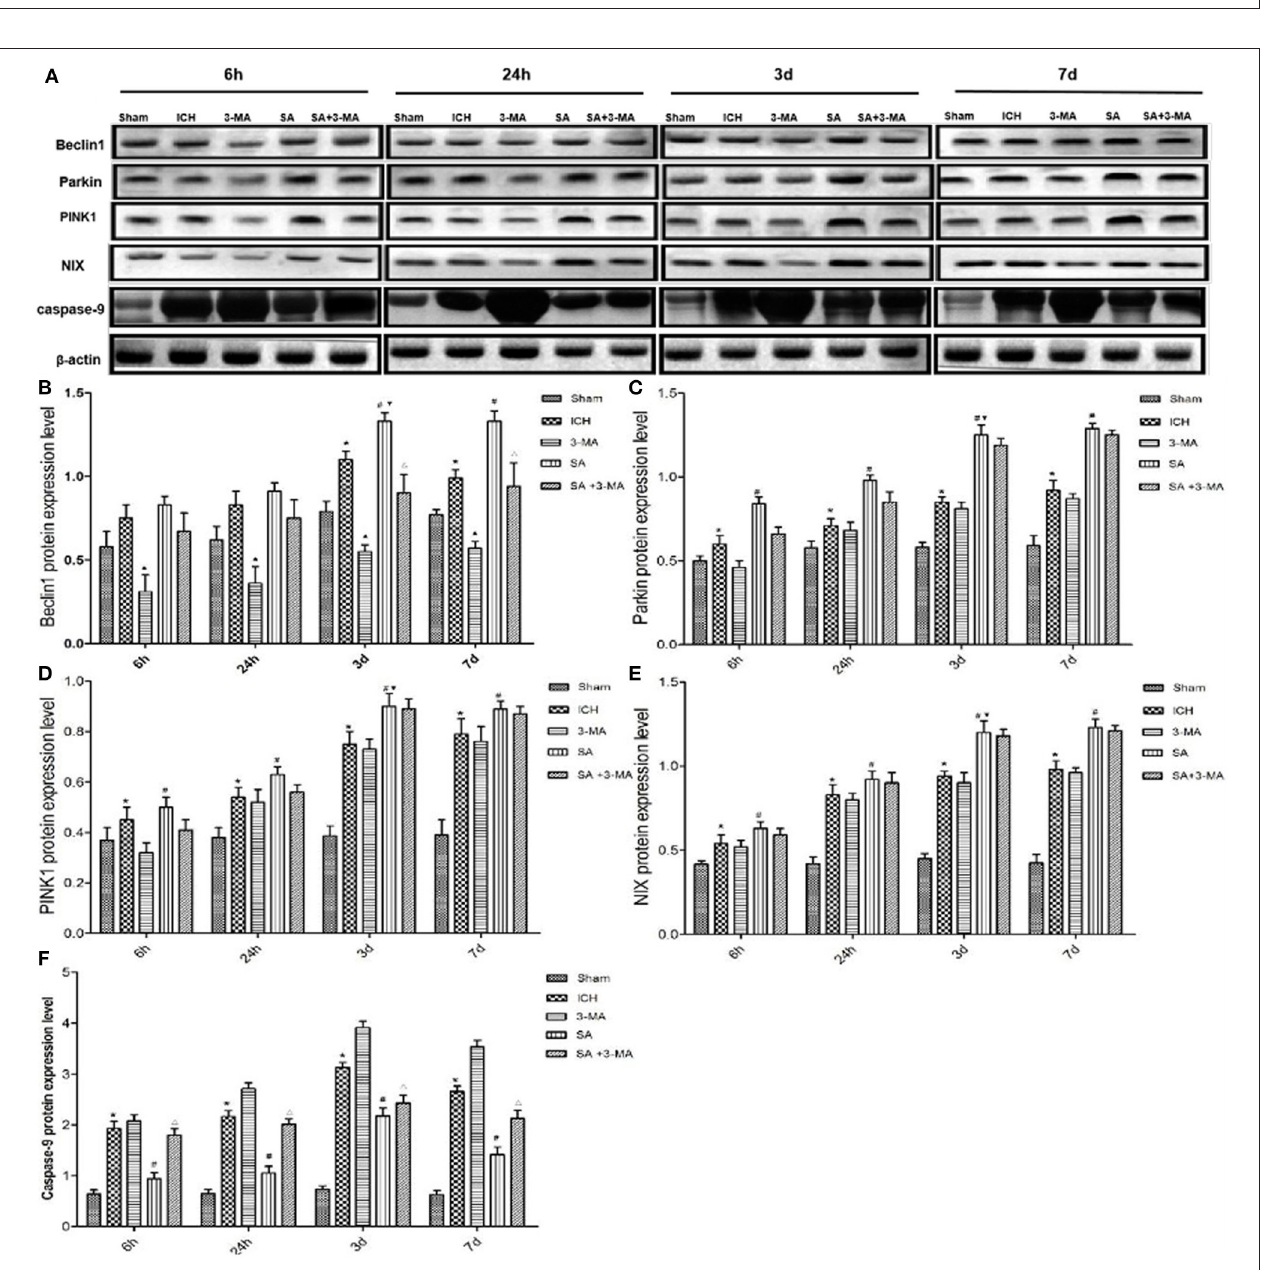
FIGURE 6 | for Beclin1, PINK1, Parkin, NIX and apoptotic cells in fields of view at 400 × magnification. Data are mean ± SD ( n = 6). Significance was assessed by one-way ANOVA, followed by Tukey’s post hoc test. * P < 0.05, vs . sham; # P < 0.05, vs . ICH; N P < 0.05, vs . ICH; 1 P < 0.05, vs . SA; H P < 0.05, vs . 24h SA group.